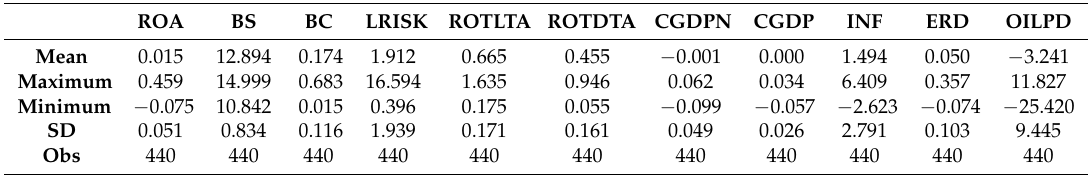
Table 3. Descriptive statistics.